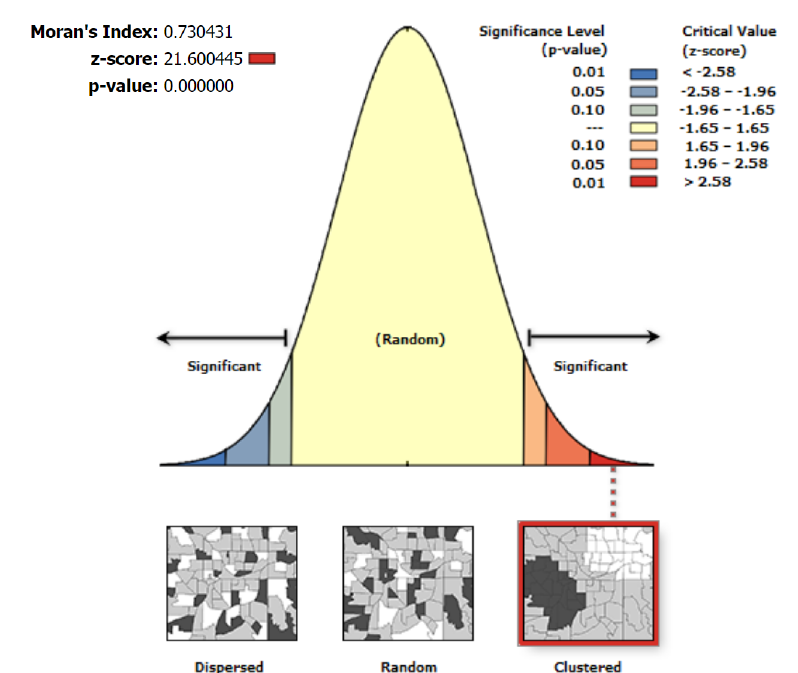
Figure 10. The spatial autocorrelation bell curve for vaccination centers.